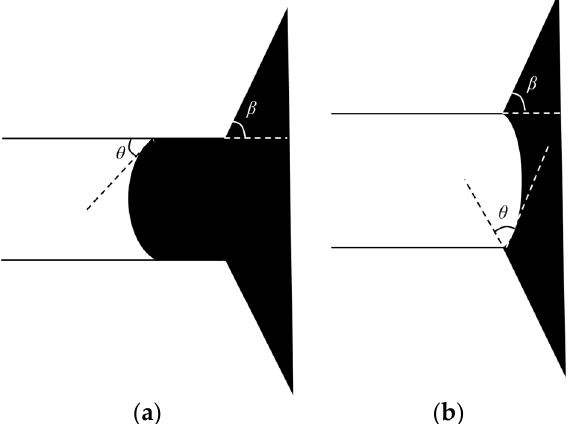
Figure 3. Oil and water distribution at different locations: ( a ) interface at the throat channel; ( b ) interface at the outlet section.